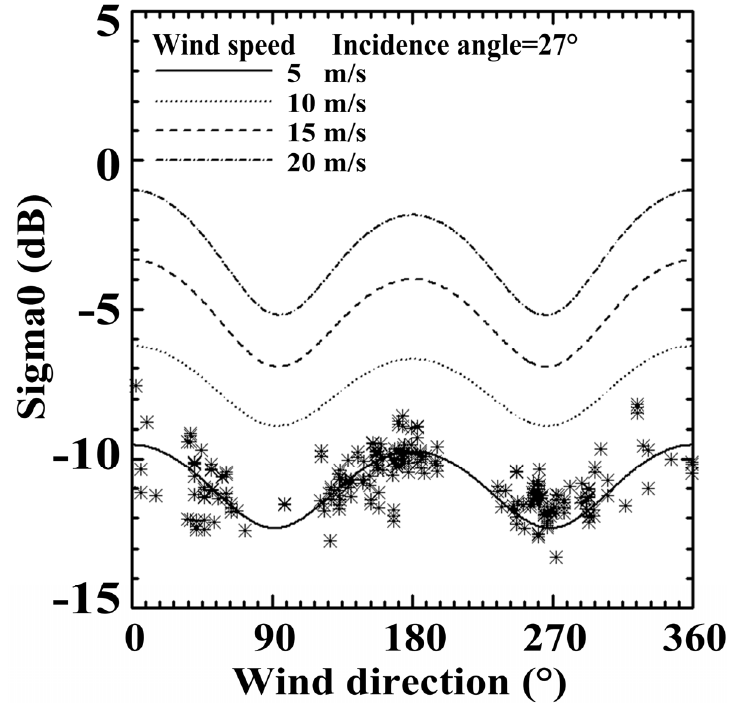
Figure 8. NRCS values simulated using the SIRX-MOD model for various wind directions with an incidence angle of